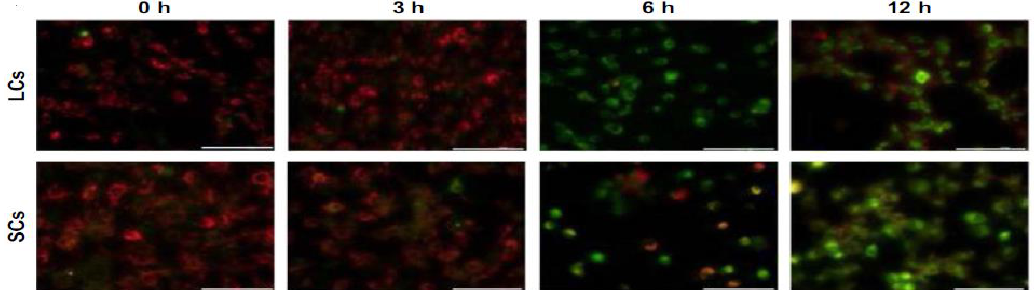
Figure 23. Viability of ( a ) Leydic cells and ( b ) Sertoli cells treated with ZnO NPs of various concentrations for 12 and 24 h as determined with MTT cell proliferation assay. LDH leakage level of ( c ) Leydic cells and ( d ) Sertoli cells. Data are presented as mean ± standard deviation of three separate experiments, in triplicate. * p < 0.05, ** p < 0.01. Reproduced from [143] under the Creative Commons Attribution – Non Commercial (unported, v3.0) license.